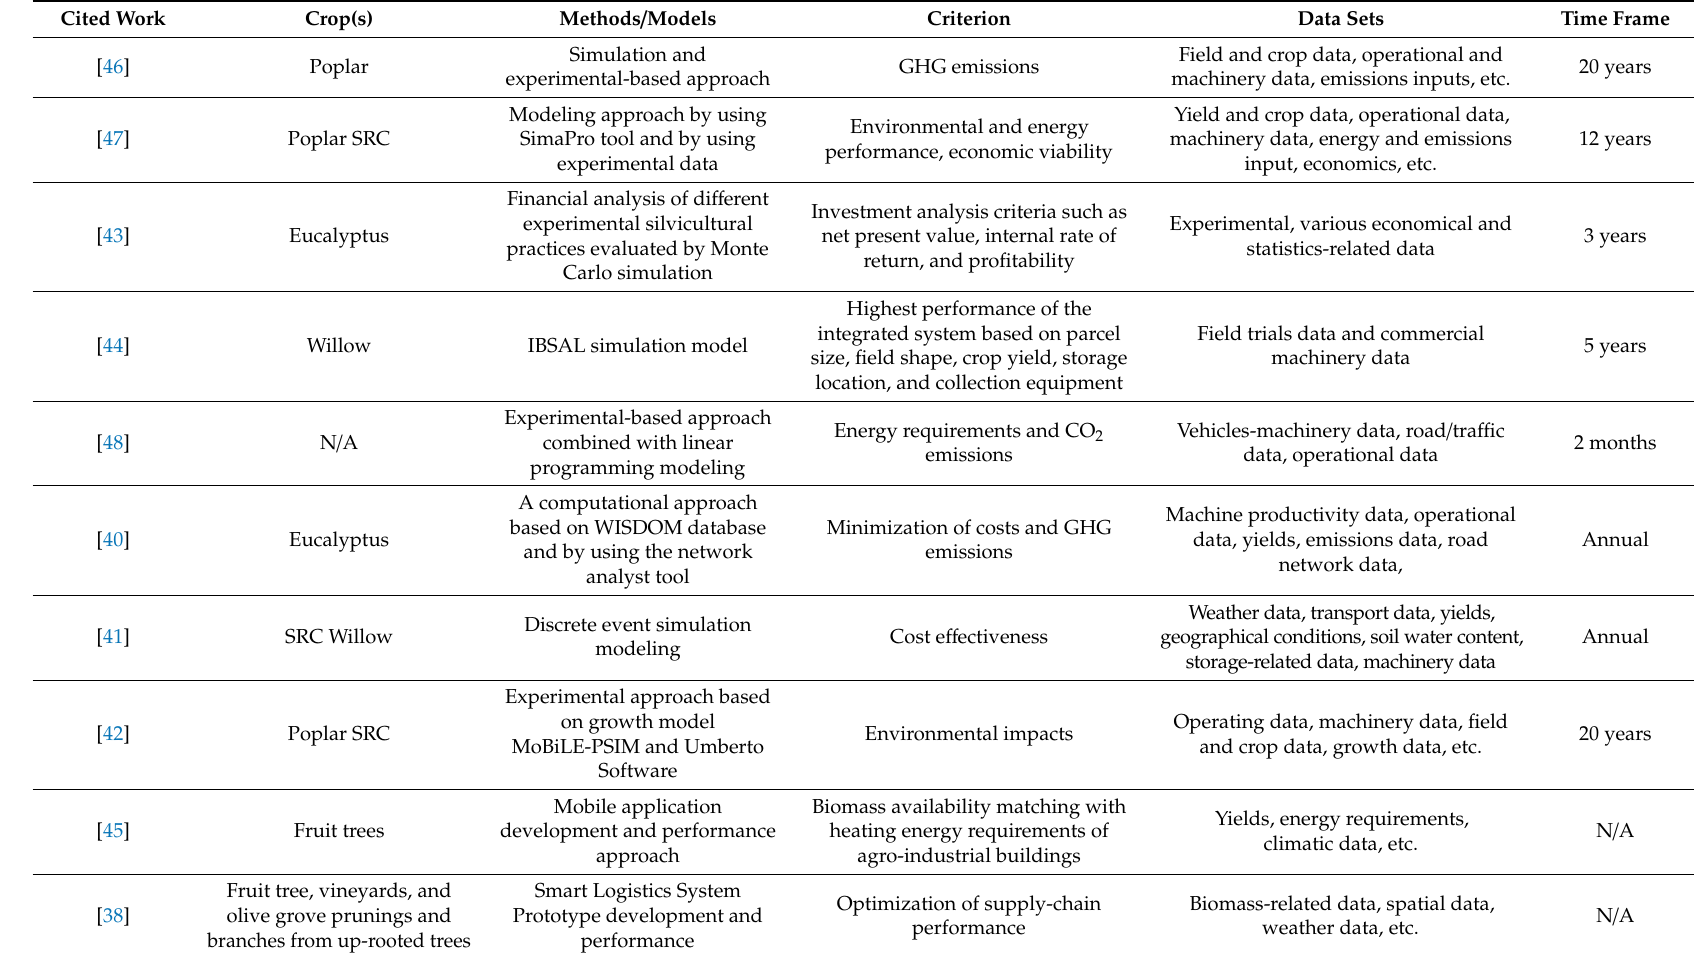
Table 3. Woody-type biomass cited studies classified by crop and